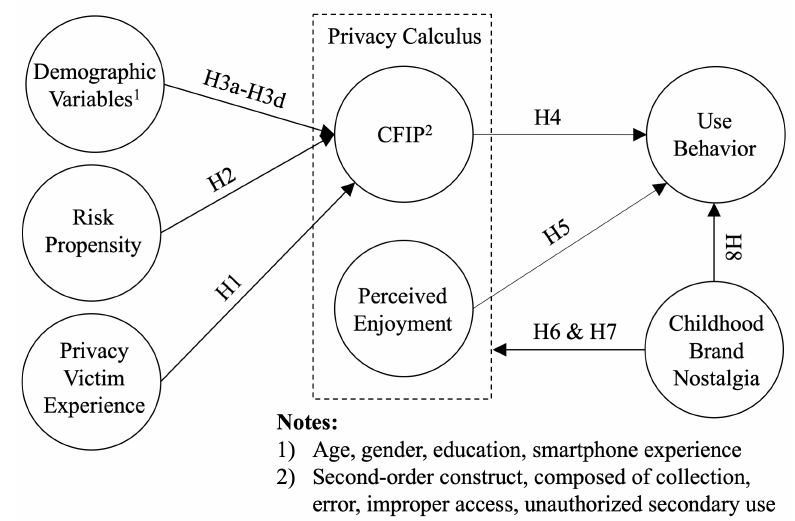
Figure 2. Research